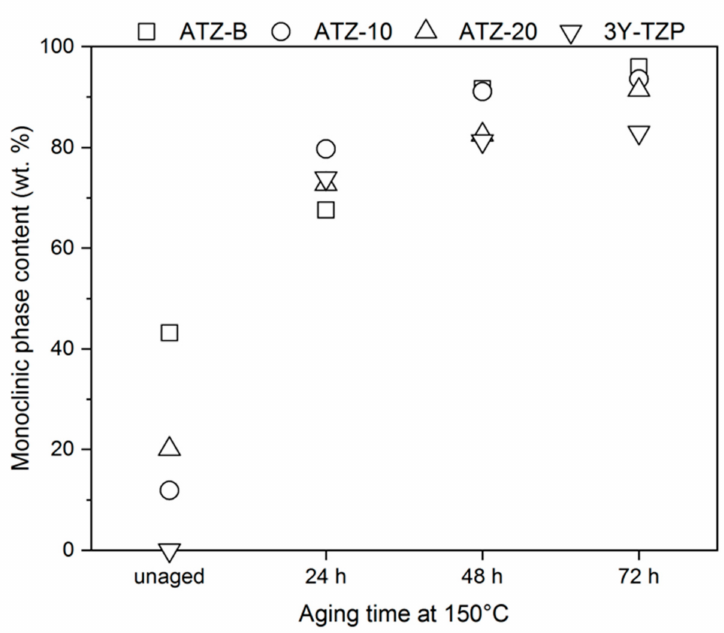
Figure 3. The monoclinic ZrO 2 mass content of the investigated materials as a function of hydrother- mal aging time at 150 ◦